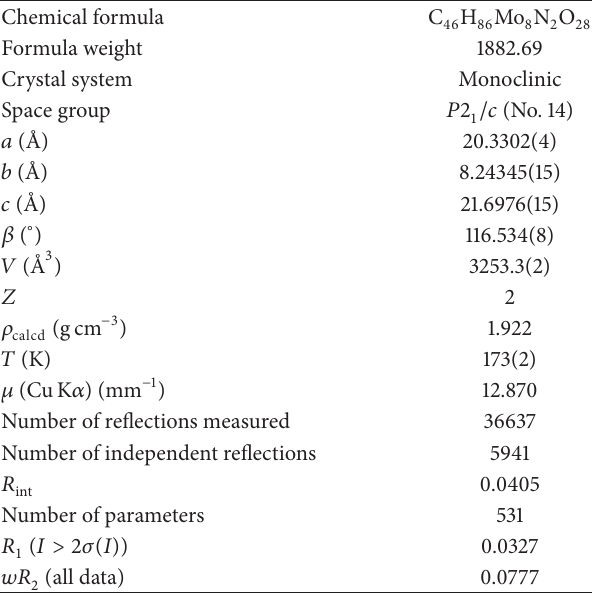
Figure 2: Powder X-ray diffraction patterns of C 16 py-H 2 Mo 8 from (a) observed data measured at ambient temperature and (b) calculated data using the structure obtained by single-crystal X-ray diffraction. Table 1: Crystallographic data for C 16 py-H 2 Mo 8 .